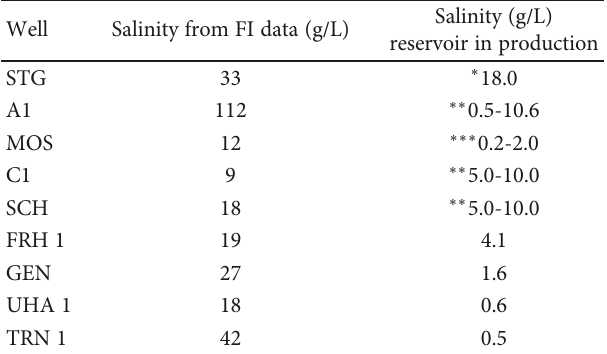
Table 3: Fluid composition of the geothermal wells in the southern Molasse Basin. Well Salinity from FI data (g/L)